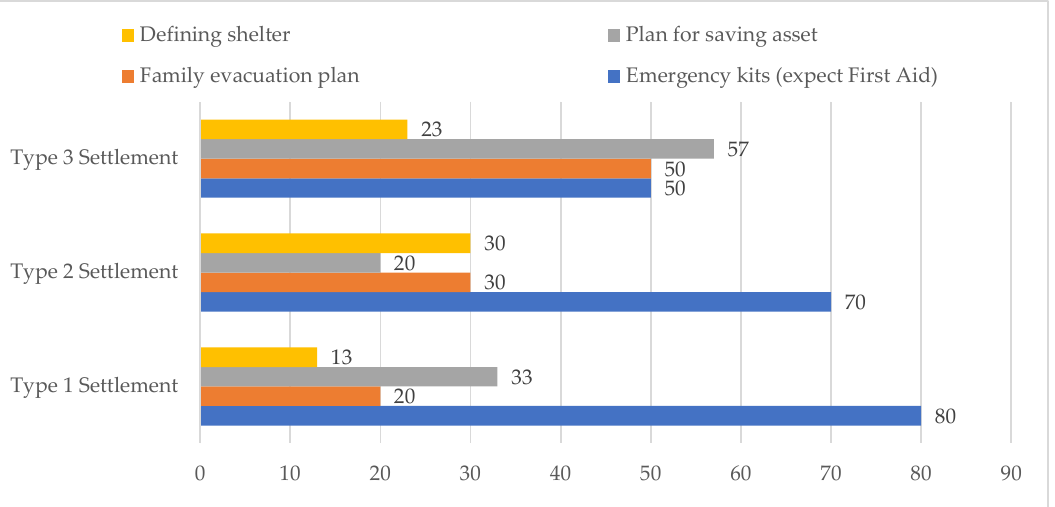
Figure 4. Status of family-level preparedness shared by respondents (%) in three settlements. The study entailed 90 respondents in three areas with equal sample size (n = 30). Source: survey.